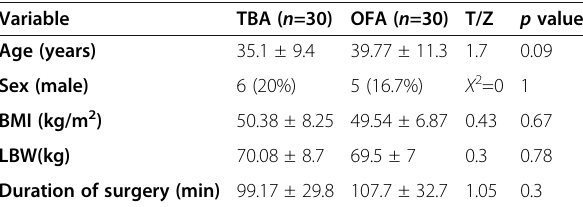
Table 3 Comparison between groups with regard to extubation time and time to reach an Aldrete score of 9